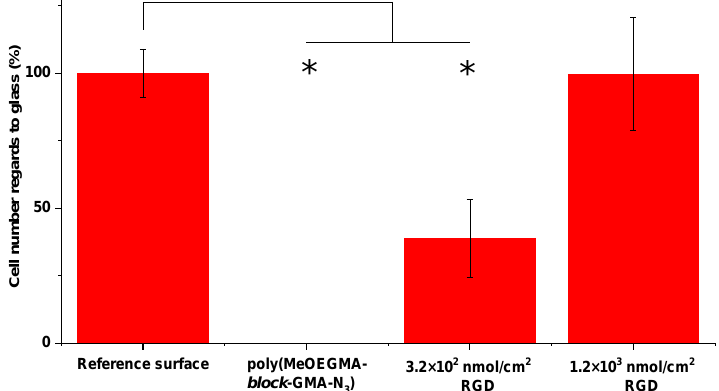
Figure 5. Relative number of HUVEC cells on tested surfaces determined from live / death assay. While the pristine poly(MeOEGMA- block -GMA-N 3 ) brushes completely canceled out the cell adhesion and viability, the brush with 1.2 × 10 3 nmol / cm 2 RGD showed similar number of adherent and viable cells as the reference glass surface. Significant di ff erences between the number of cells were calculated by the student t-test (* p < 0.05).